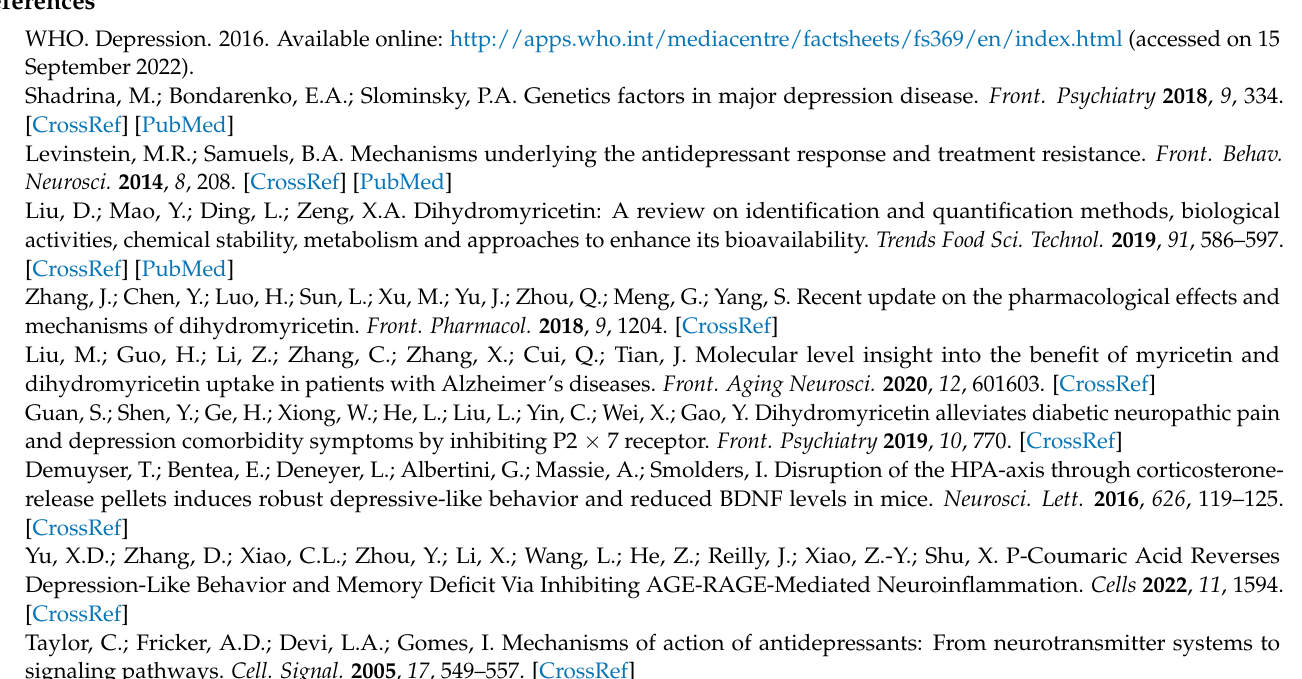
blot for Figure 7A; Table S1: Targets of dihydromyricetin; Table S2: Targets of depression; Table S3: Intersecting